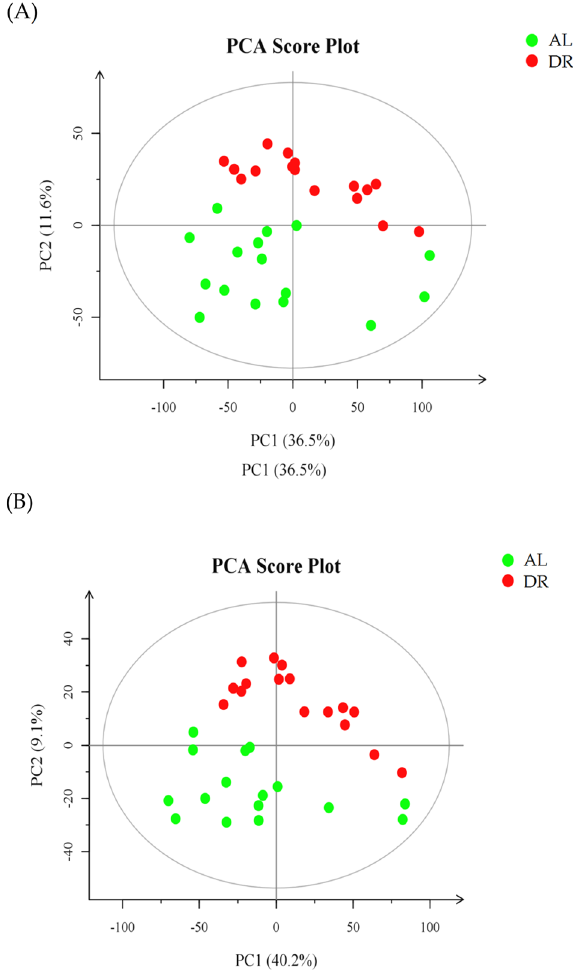
Figure 2. Scatter plot of the principal component analysis. ( A ) positive ion mode; ( B ) negative ion mode. Note AL, ad libitum feeding; DR, Dietary restriction.